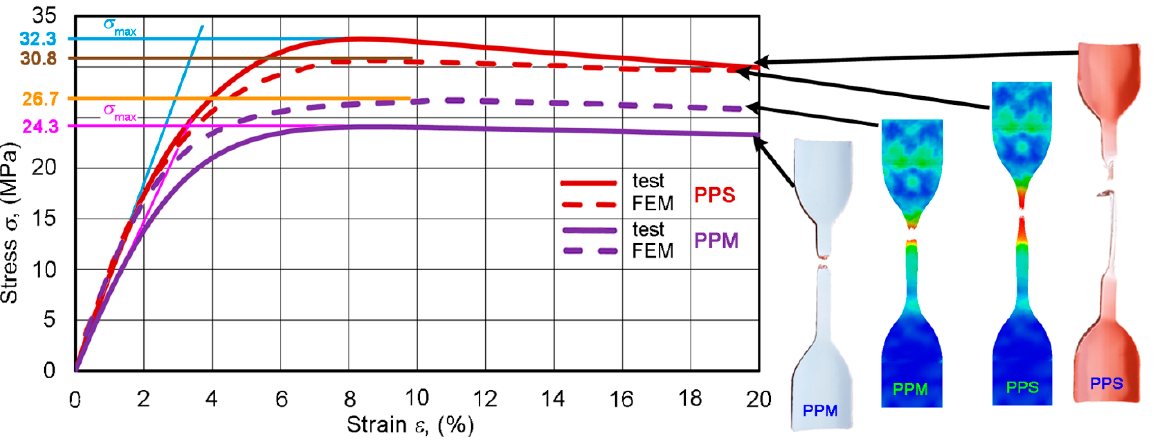
Figure 10. Comparison of FEM and experimental results in the tension of PPS and PPM pipe samples.